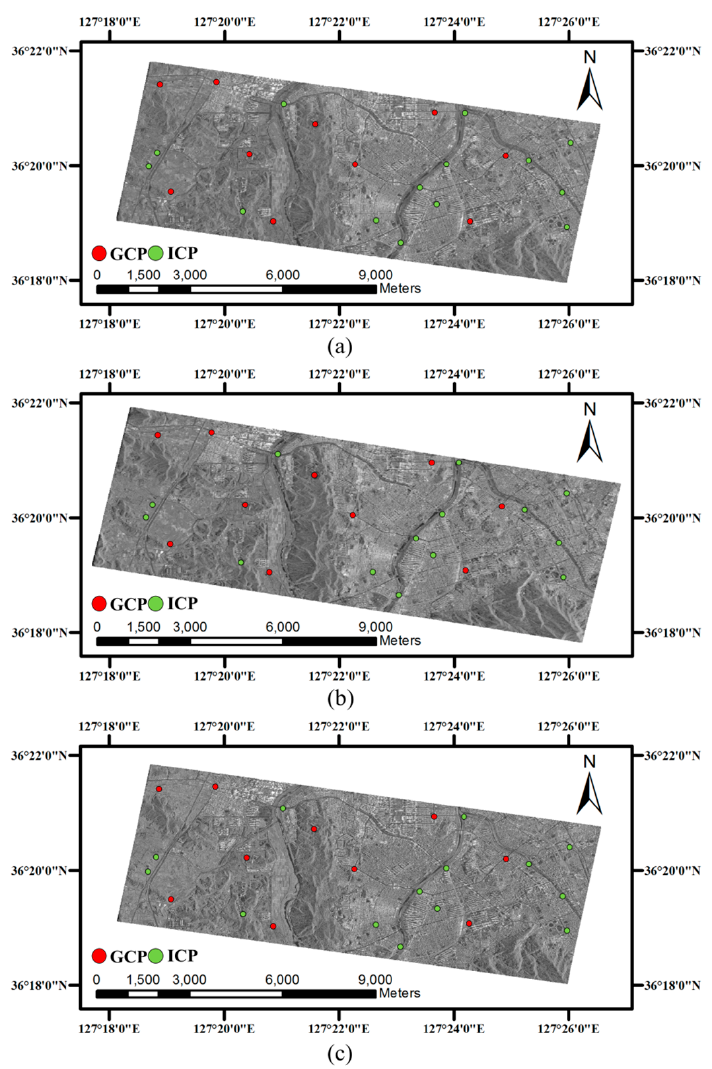
Figure 1. TerraSAR-X images and location of GCPs and ICPs: ( a ) TSX 1 (4 April 2009); ( b ) TSX 2 (9 April 2009); ( c ) TSX 3 (23 July 2009).